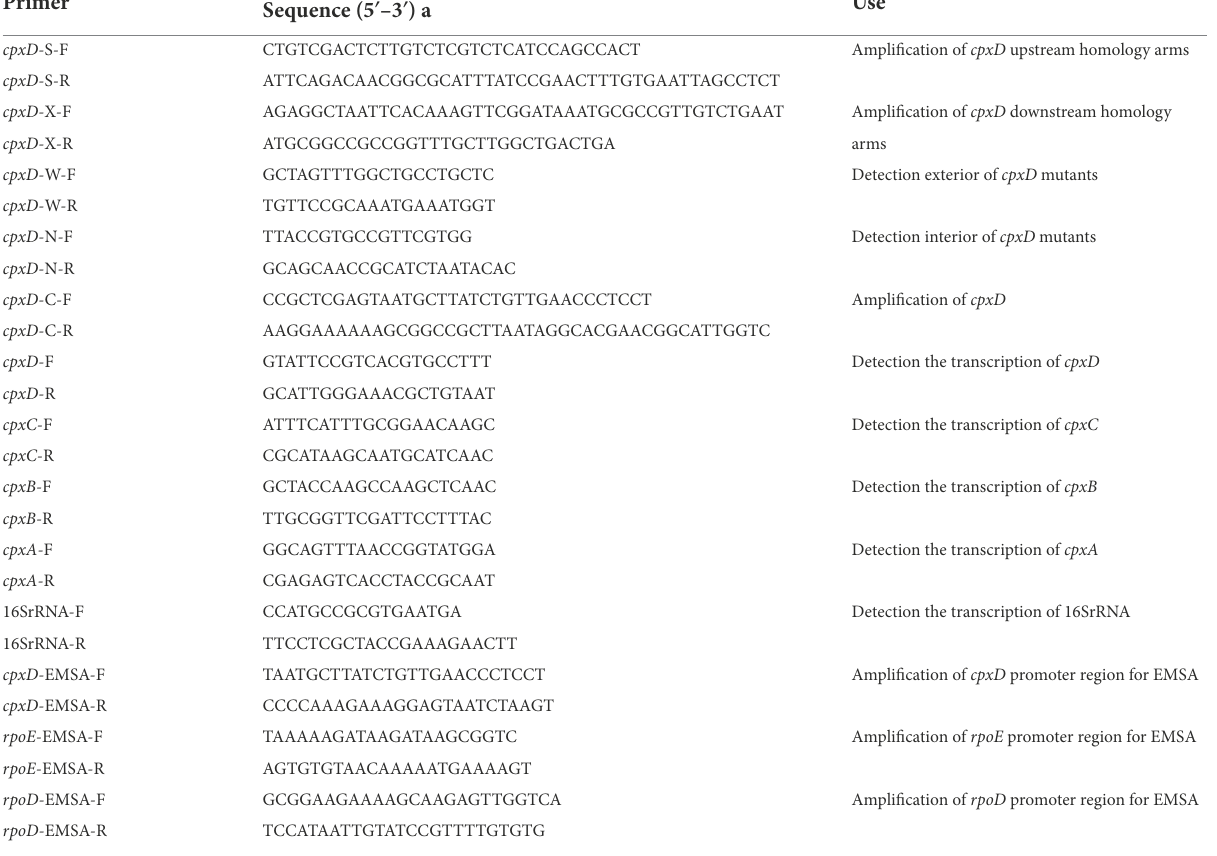
TABLE 2 Primers used in this